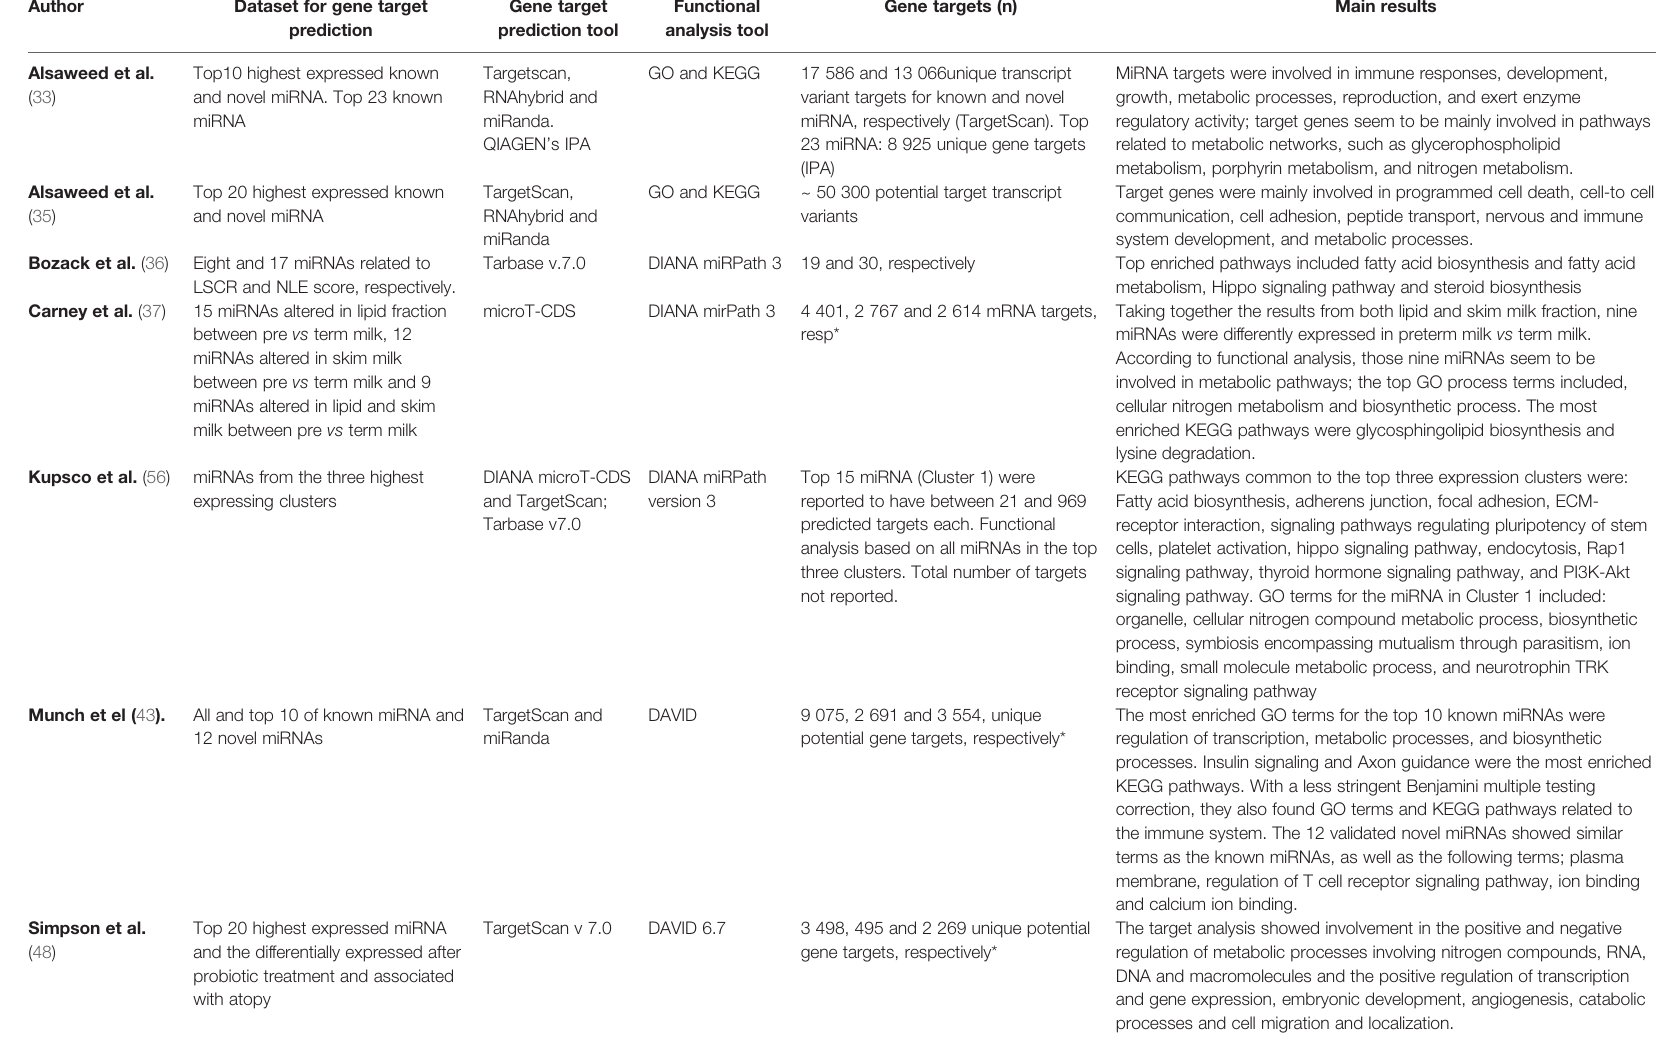
TABLE 5 | miRNA gene target analysis and functional